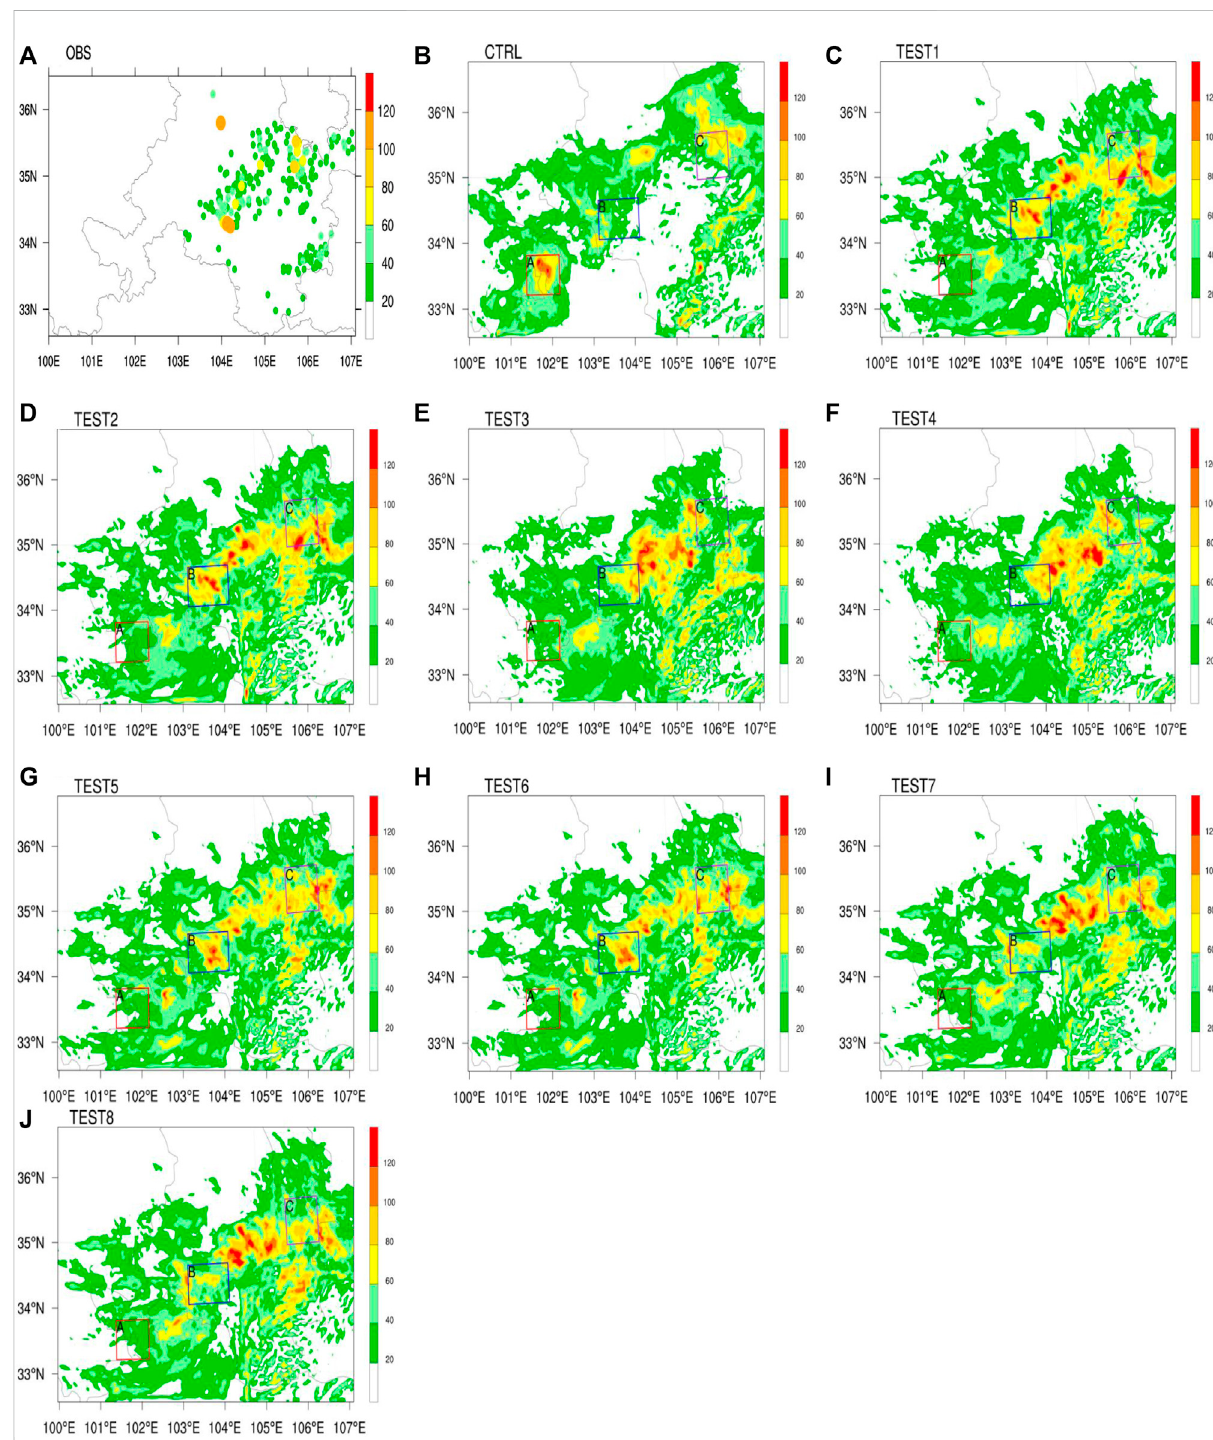
FIGURE 1 24-h precipitation distribution map (0800 BT June 22 to 0800 BT 23 June 2016, units: mm) (A) Observation by the Gansu Provincial Regional Station (B) CTRL (C – J) TESTs 1 –